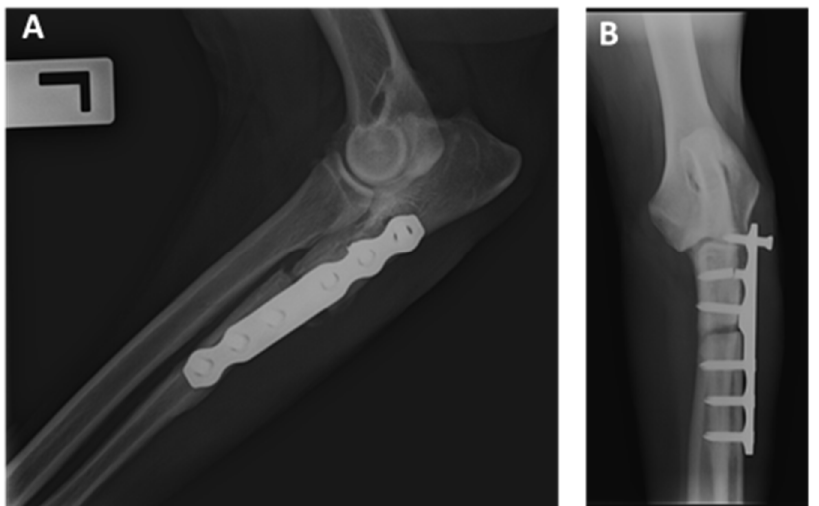
Figure 6. ( A ) Lateral and ( B ) cranio-caudal projection of the left elbow at 4 months after surgery. Delayed union and osteolysis due to the instability were identified. At the same time, the caudal placement of the plate in the ulna lead to greater stress on these implants (dog 12, Table